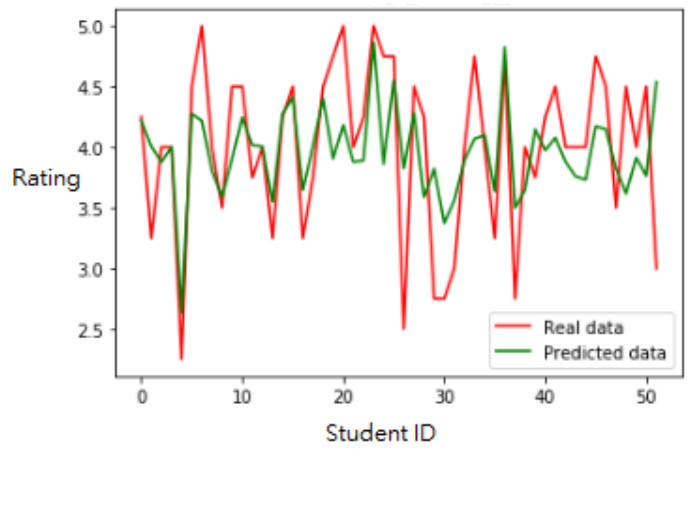
Figure 2 Example of Satisfaction Score Prediction Model Based on Learning